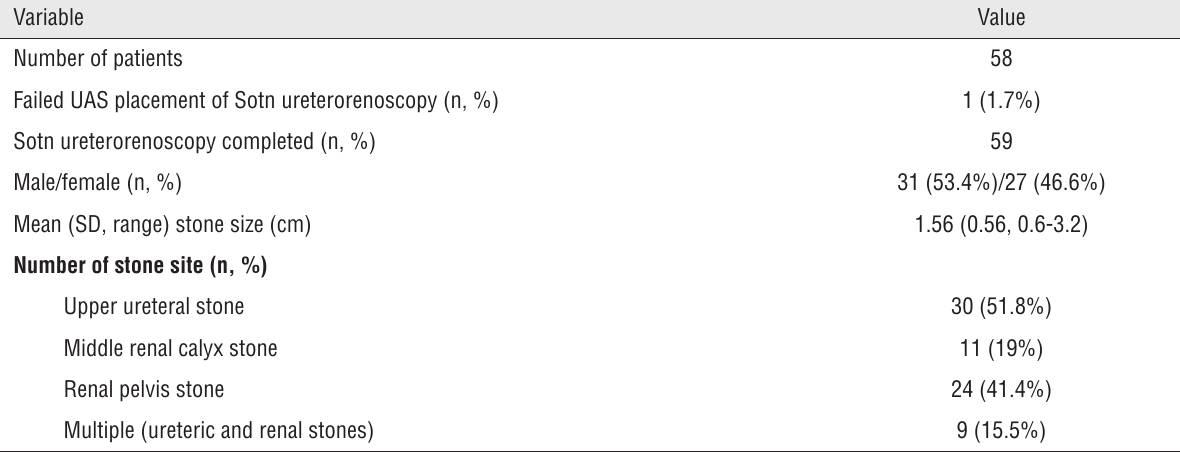
Table 1 - Demographics and stone characteristics of patients who underwent Sotn ureterorenoscopy. Variable Value Number of patients 58 Failed UAS placement of Sotn ureterorenoscopy (n, %) 1 (1.7%) Sotn ureterorenoscopy completed (n, %) 59 Male/female (n, %) 31 (53.4%)/27 (46.6%) Mean (SD, range) stone size